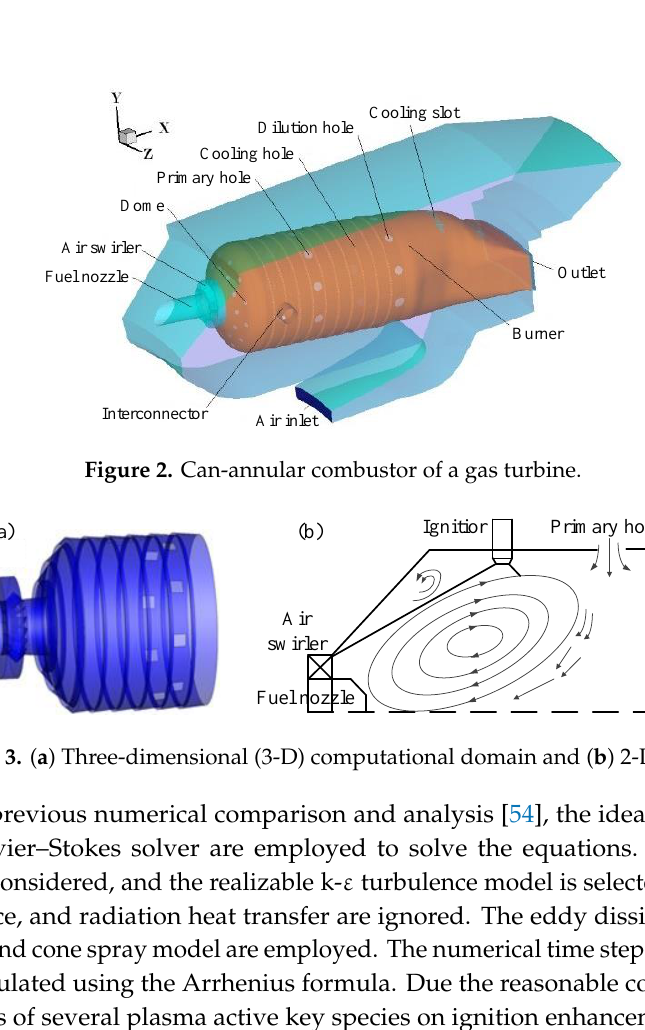
Figure 3. ( a ) Three-dimensional (3-D) computational domain and ( b ) 2-D profile.